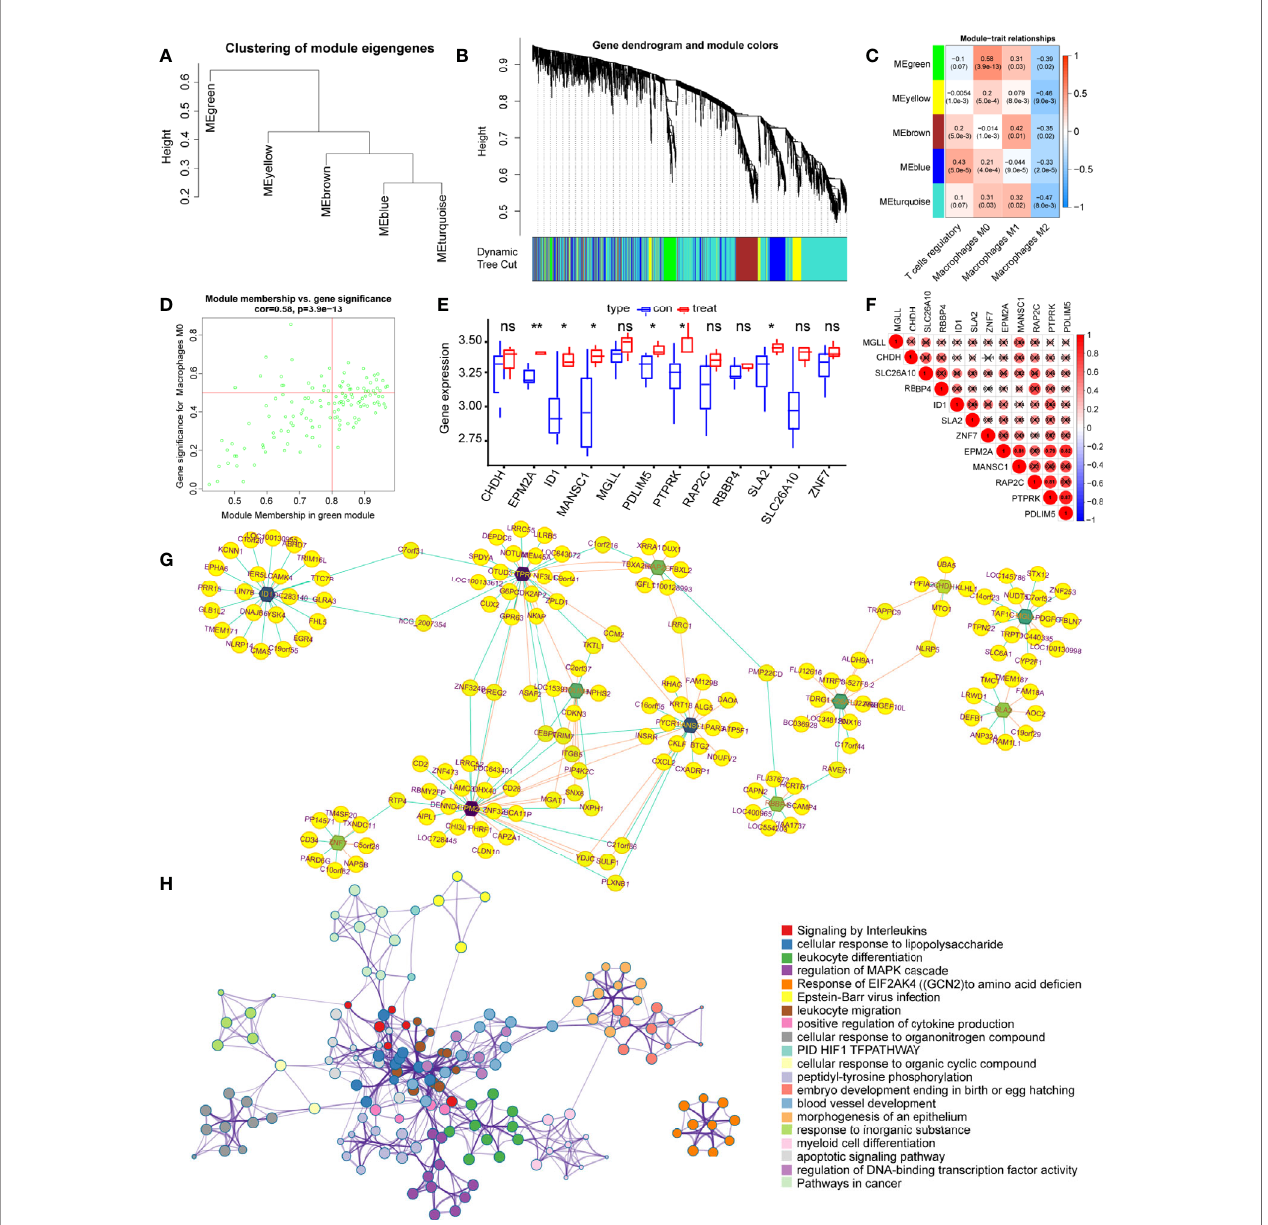
FIGURE 3 | Identi fi cation of the key modules and genes that relate to immune in fi ltration features in intervertebral disc degeneration. (A, B) The construction of the co-expression network module clustering tree based on the 1-tom matrix. (C) Feature of each merged module relationship, with different colors representing different modules. Each row corresponds to a module and columns represent their correlations with the traits. Each unit includes the correlation coef fi cient and p-value. (D) Genes of the selected green module. (E) The hub gene expression levels in different groups. (F) Expression correlation matrix of each hub gene in lumbar disc herniation. (G) The gene regulation networks are constructed to identify the hub genes. The edge represents the protein binding conditions and the node represents each gene. Darkness of the node represents the edge number of each gene. (H) The functional enrichment of the correlated genes by using metascape. Symbol "*", "**", and "ns" respectively stand for P value under 0.05, P value under 0.01, and non-signi fi